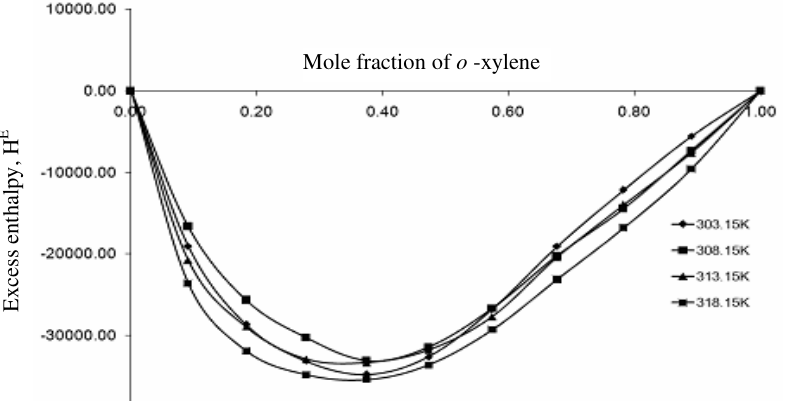
Figure 5. Variation of excess enthalpy with mole fraction at different temperatures.